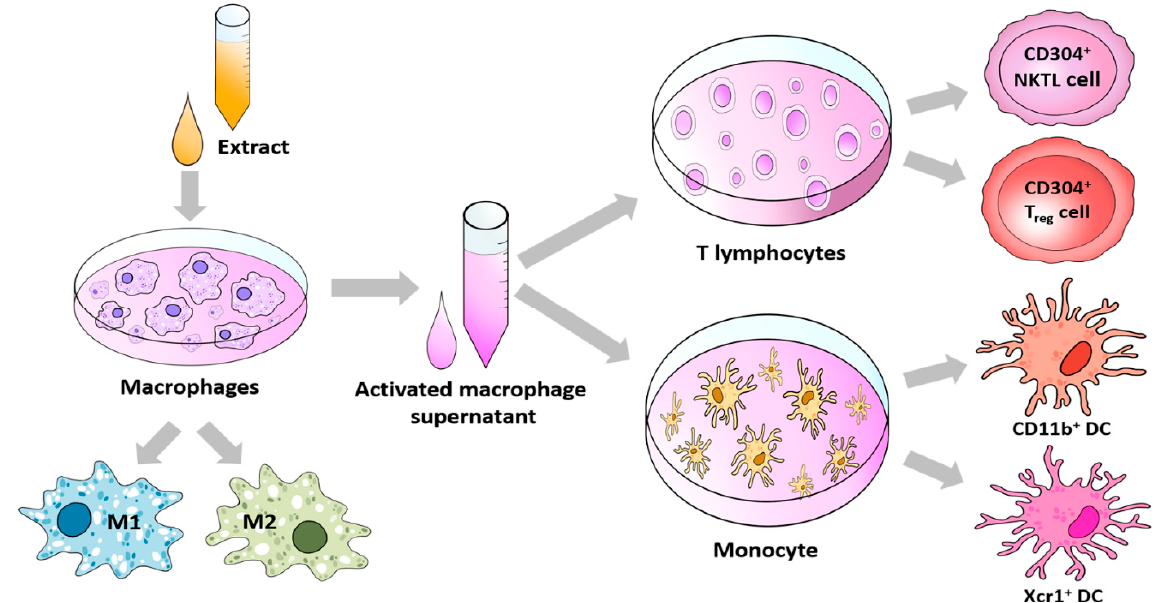
Figure 1. Schematic workflow for experimental procedures. The macrophages were exposed to the extract for the polarization. Under the extract, the supernatants derived from macrophages were collected and exposed to T cells and monocytes. M1 and 2; macrophage 1 and 2, DC; dendritic cells, NKTL cells; natural killer T-like cells.